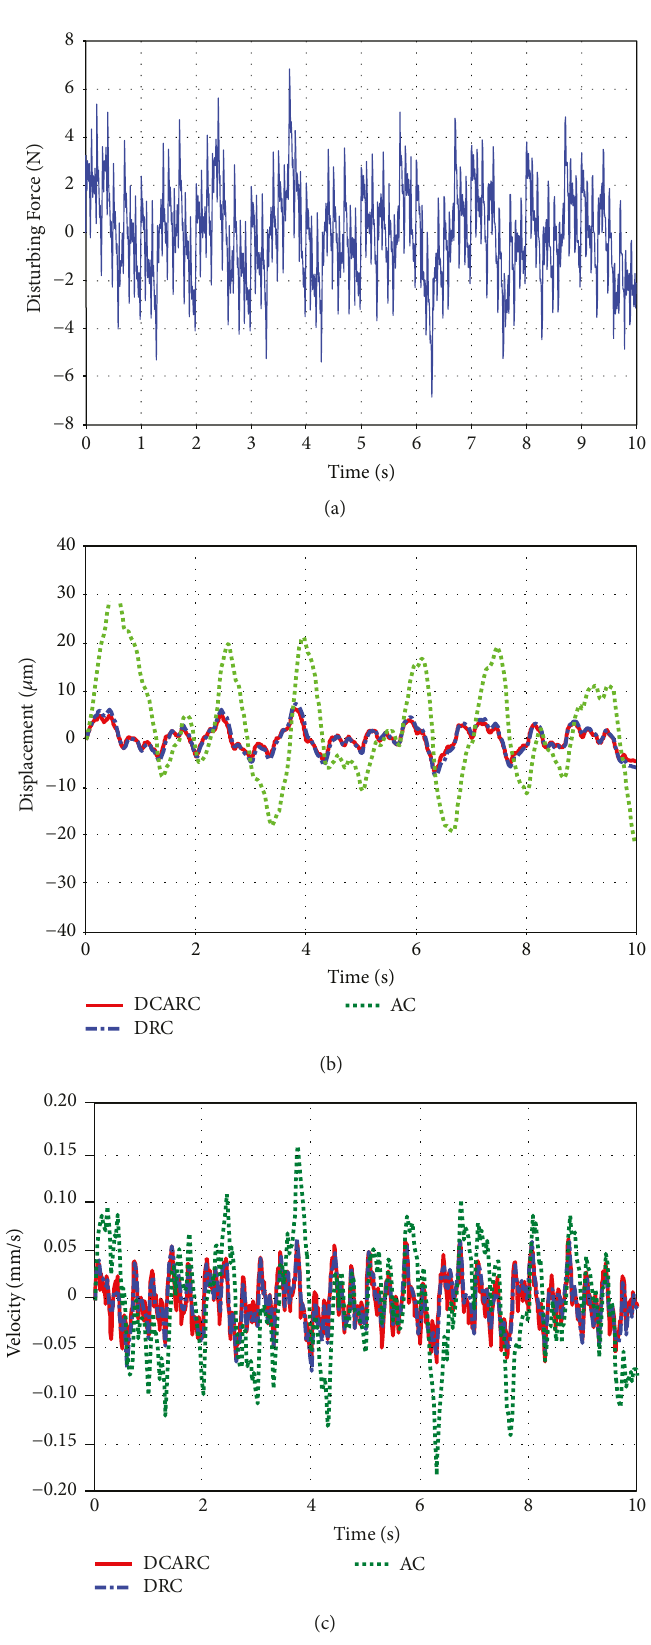
Figure 6: Rejection to disturbing force: (a) disturbing force and (b) displacement